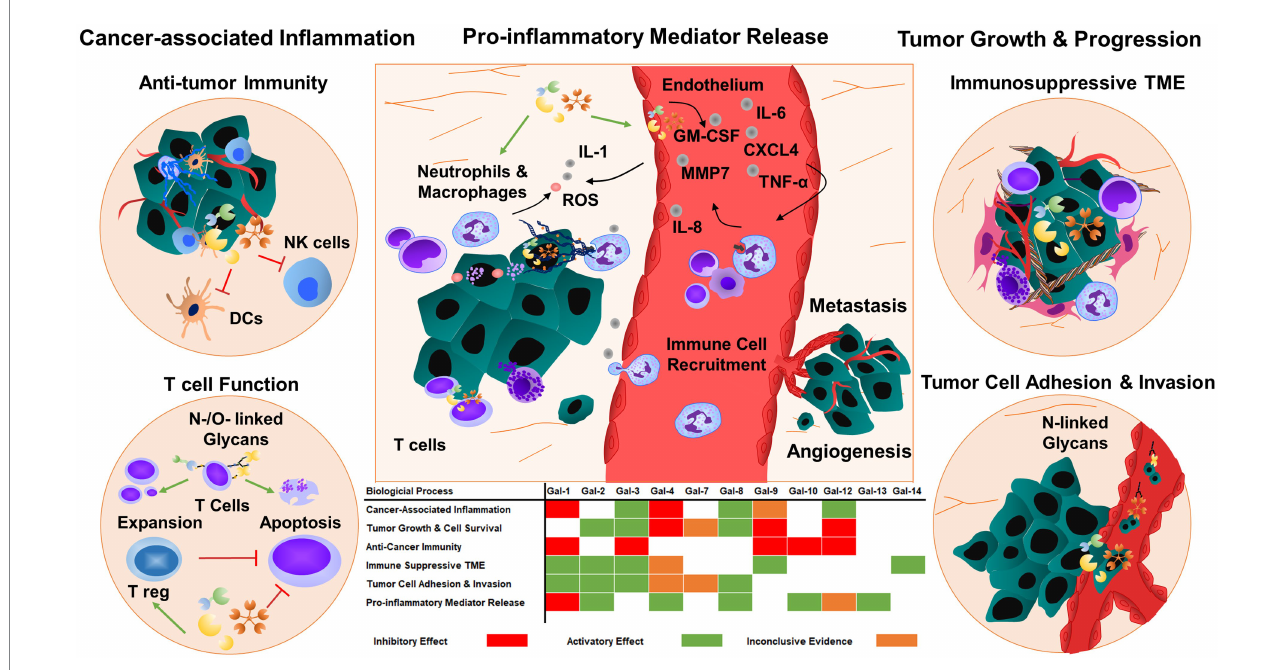
FIGURE 2 Galectins regulate tumor progression and metastasis by responding to inflammatory cues. Galectins can also prime tumor cells and tumor microenvironment to enhance tumor growth and angiogenesis by regulating cell adhesion, migration, and cytokine and chemokine release. The majority of galectins display pro-tumorigenic and metastatic functions, which promote immunosuppressive functions in immune cells and consequently inhibit anti-tumor immunity. TME: tumor